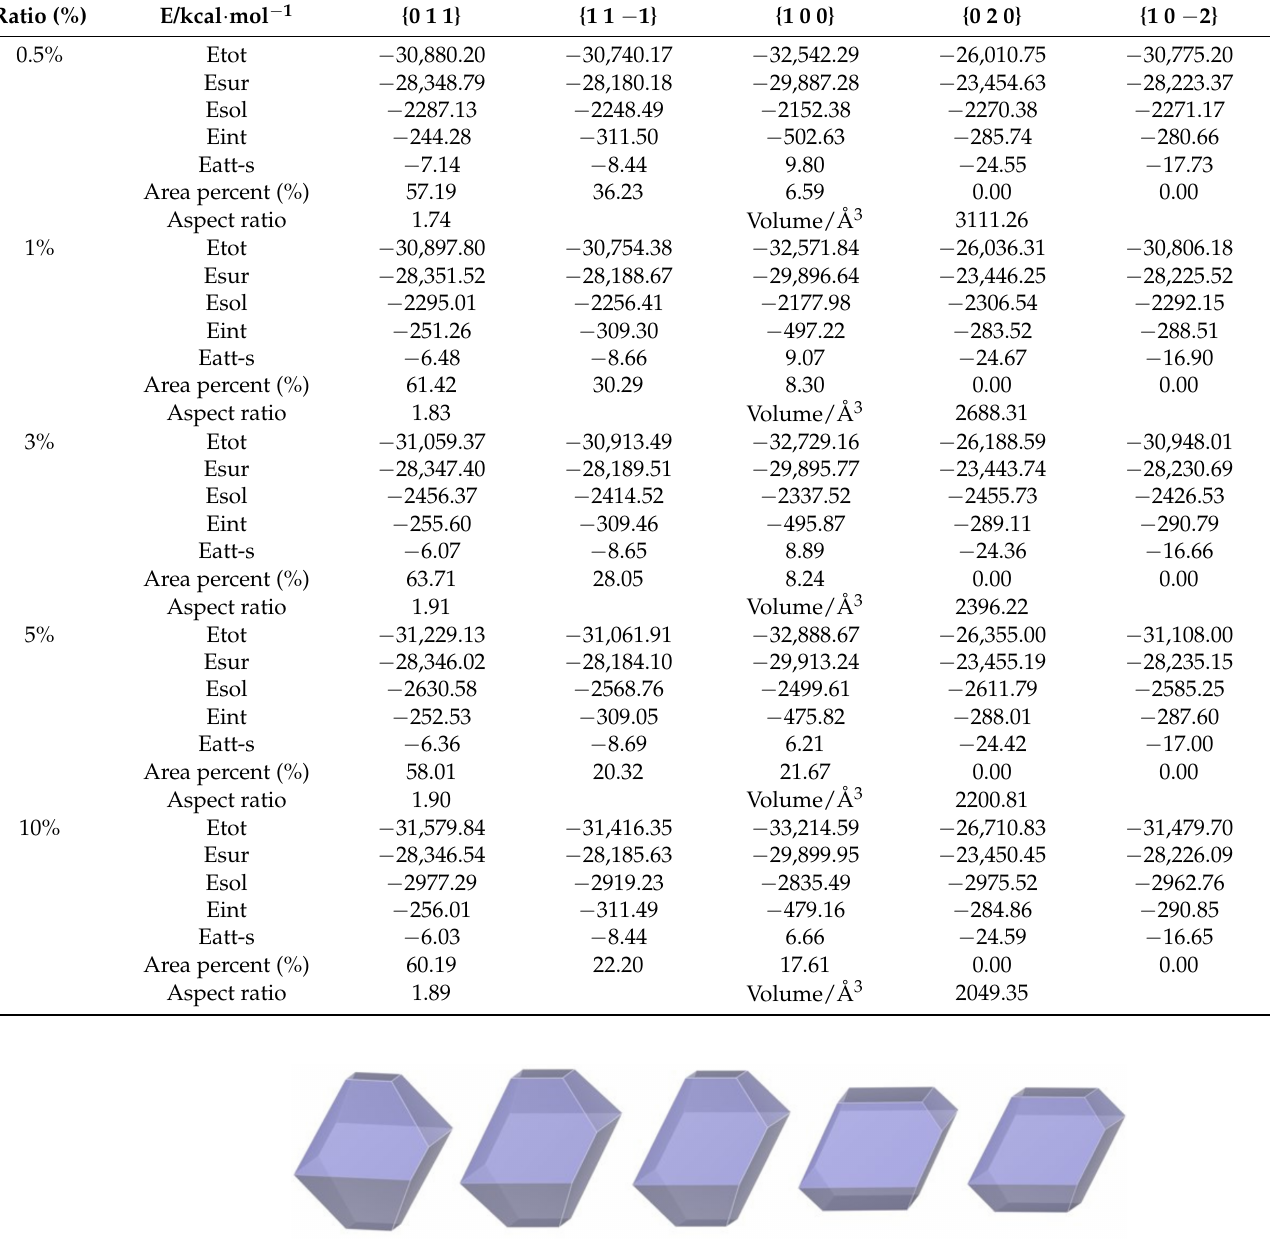
Table 5. Interaction energies and crystal habits of β -HMX in PVA–DMSO system with different mass fractions of PVA at 298 K.